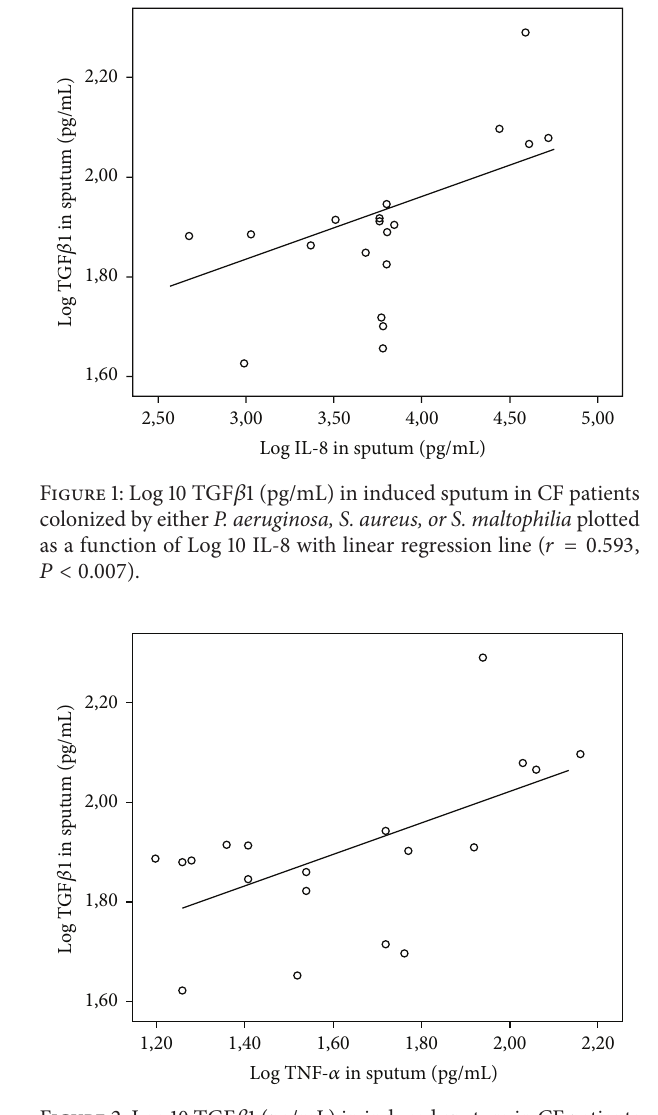
Figure 2: Log 10 TGF 𝛽 1 (pg/mL) in induced sputum in CF patients colonized by either P. aeruginosa, S. aureus, or S. maltophilia plotted as a function of Log 10 TNF-alpha with linear regression line ( 𝑟 = 0.536 , 𝑃 < 0.018